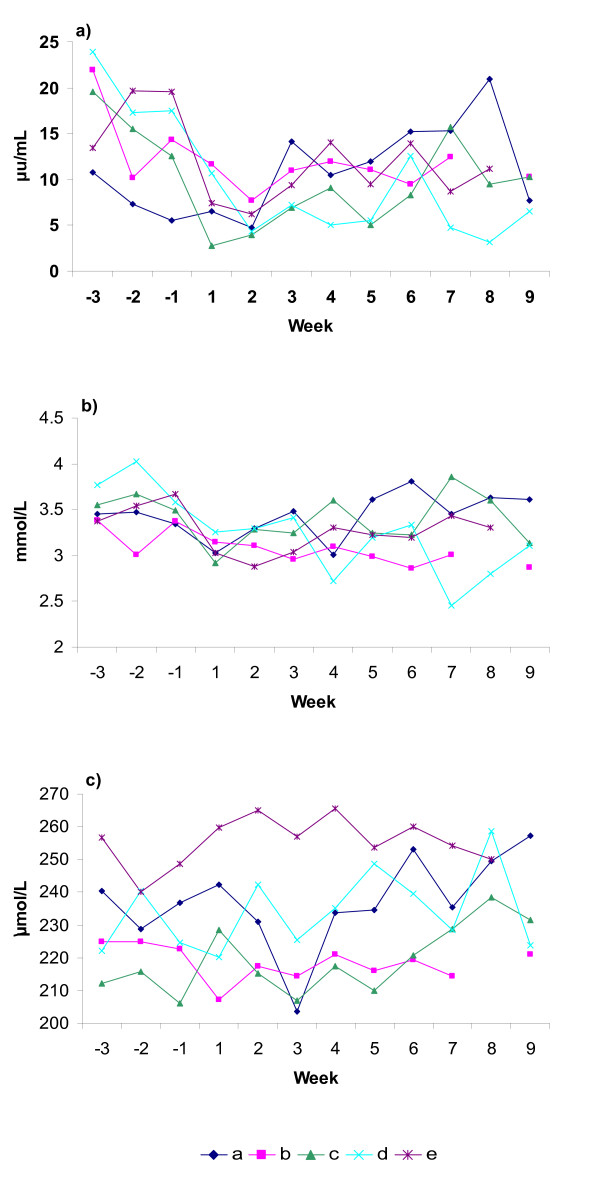
Herd-specific patterns for herd A-E shown as least-squares means. a) insulin, b) glucose and c) fructosamine.